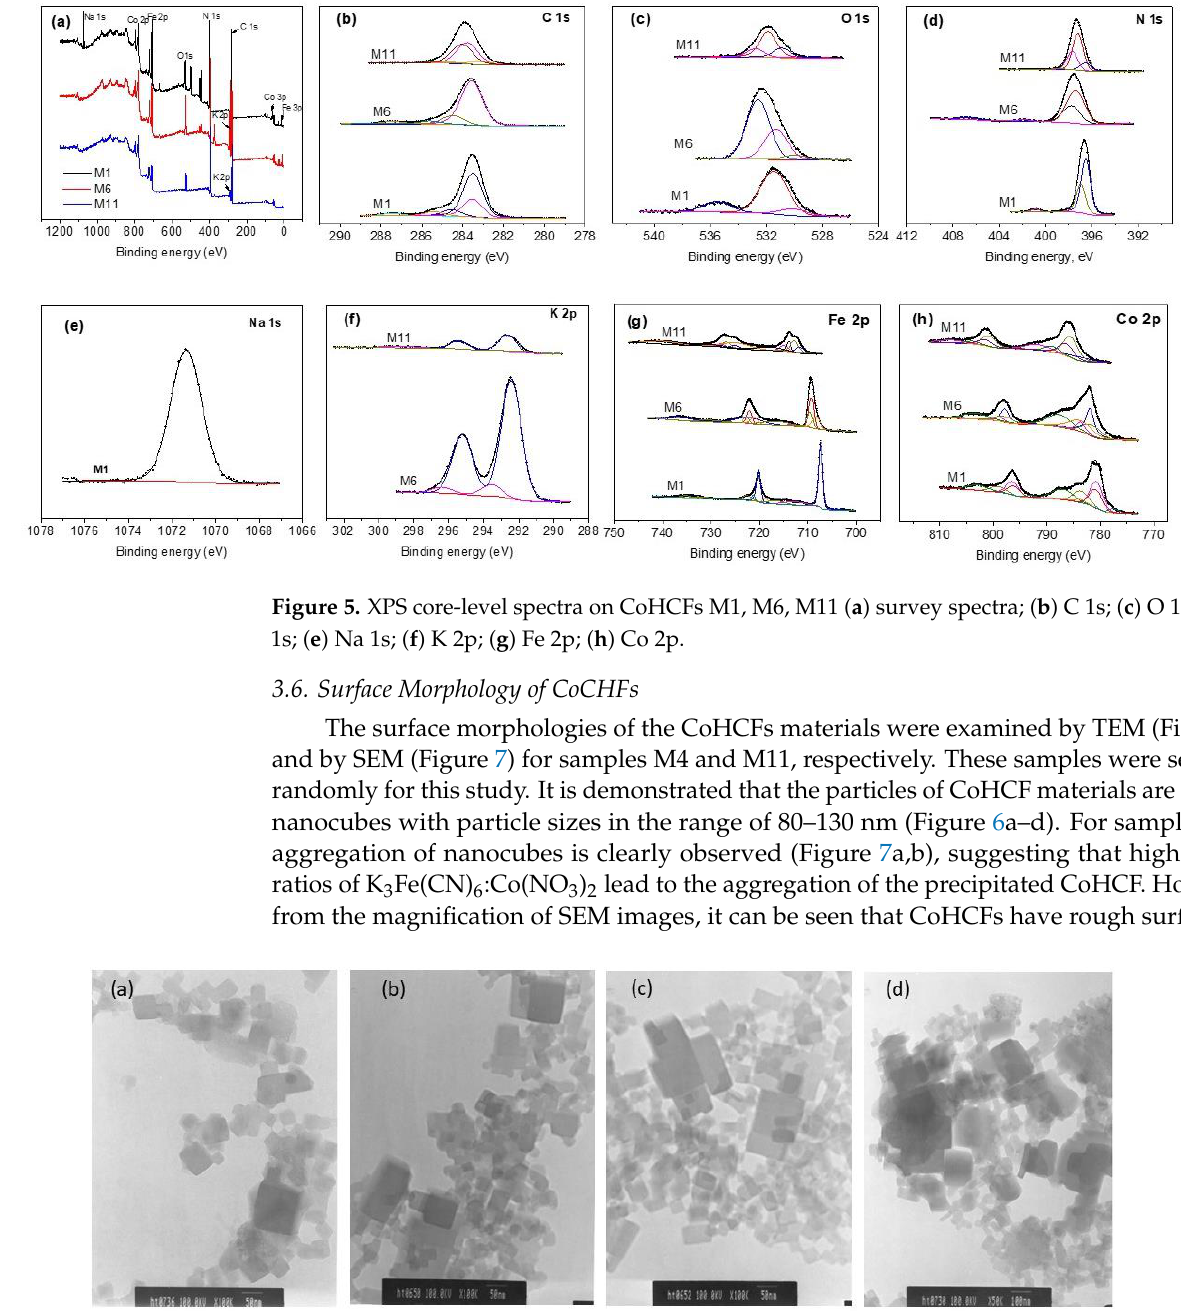
Figure 6. TEM micrographs of CoHCFs of sample M4 keeping fixed the molar ratio of Na 4 Fe(CN) 6 : Co(NO 3 ) 2 at 1.71:1, but using different amounts of reactants ( a ) 10 % wt, ( b ) 15 %wt, ( c ) 20 %wt, ( d ) 30 %wt.